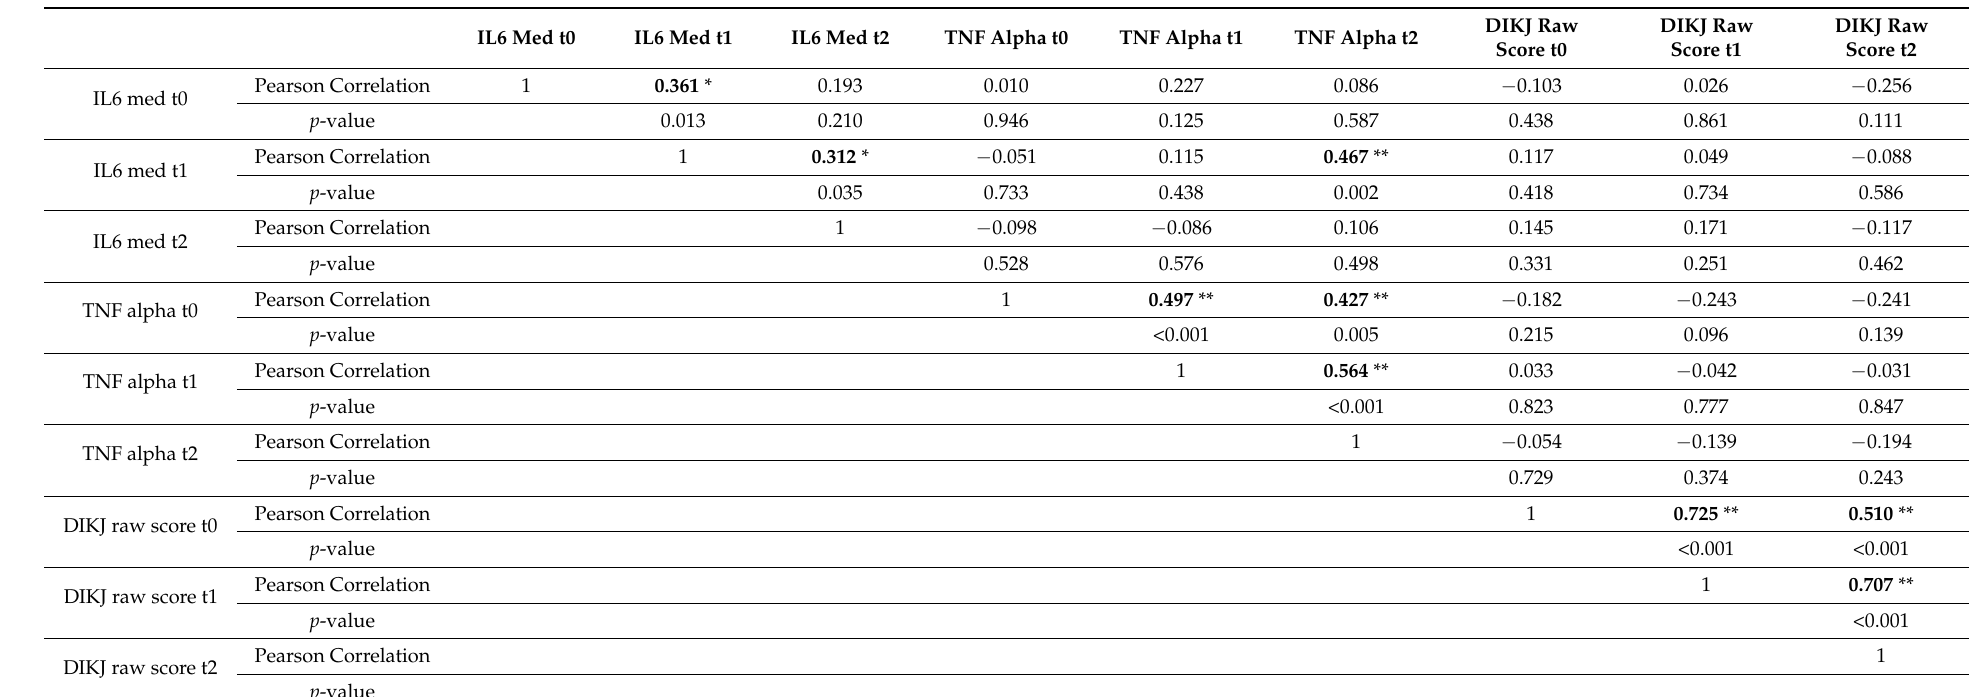
Table 5. Correlations of IL-6 and TNF- α and DIKJ at t0, t1, t2, and whole